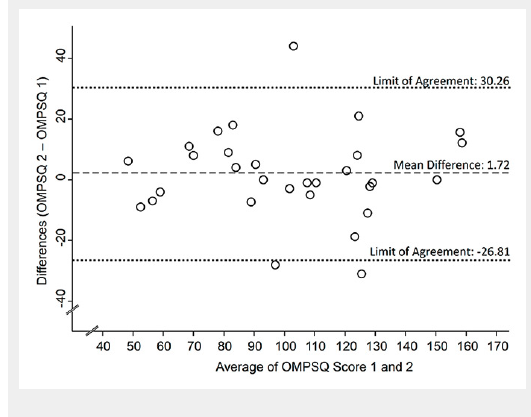
Bland–Altman plot for the Örebro Musculoskeletal Pain Screening Questionnaire (OMPSQ) total score, with limits of agreements interval (pointed line) of the mean difference (dashed line) between the two assessment occasions.